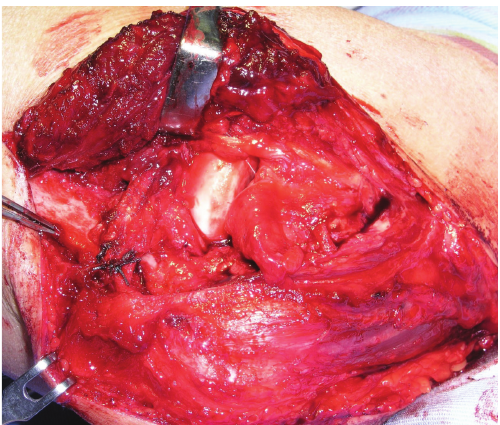
Figure 3: Fascia flap of triceps was passed around radius head, tied on the base of flap by nonabsorbable suture. The arm was then immobilized in full extension and supinated.